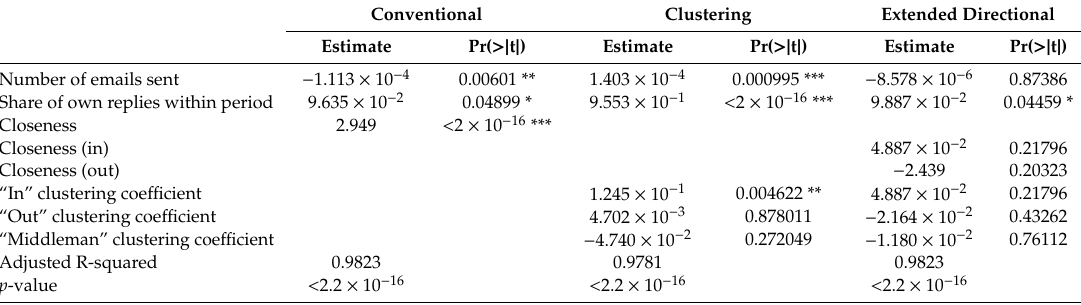
Table A1. College dataset, 7-day model.